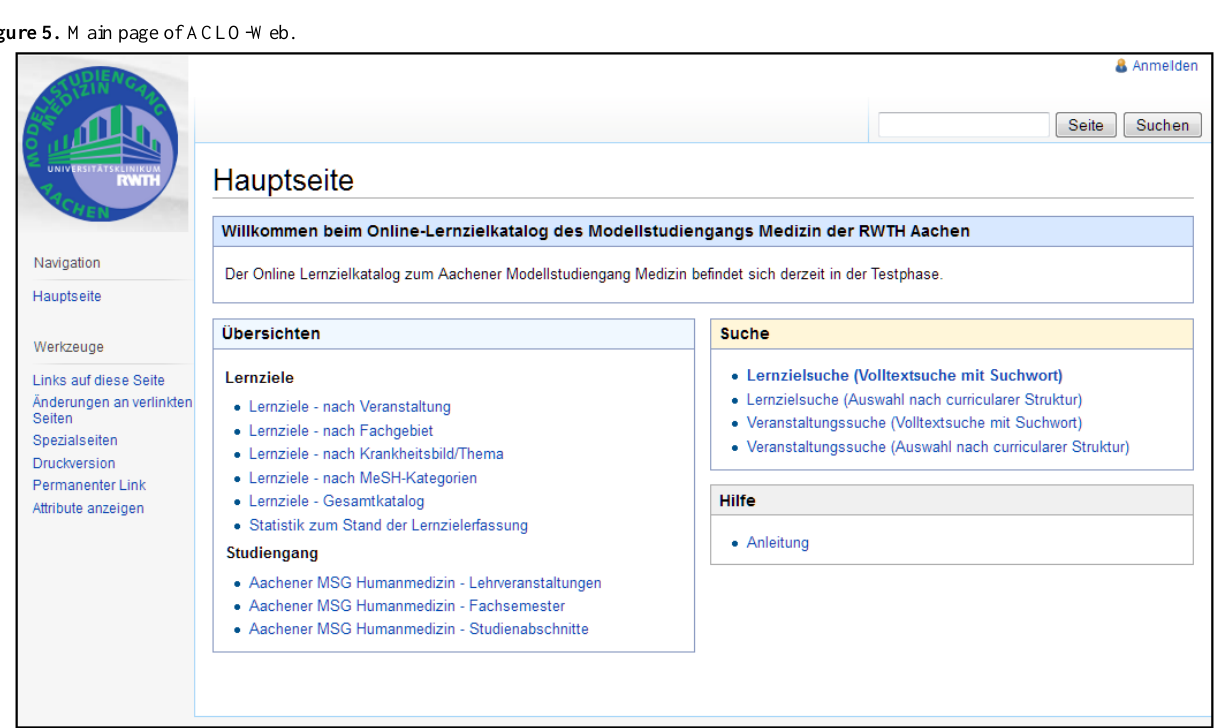
Figure 5. Main page of